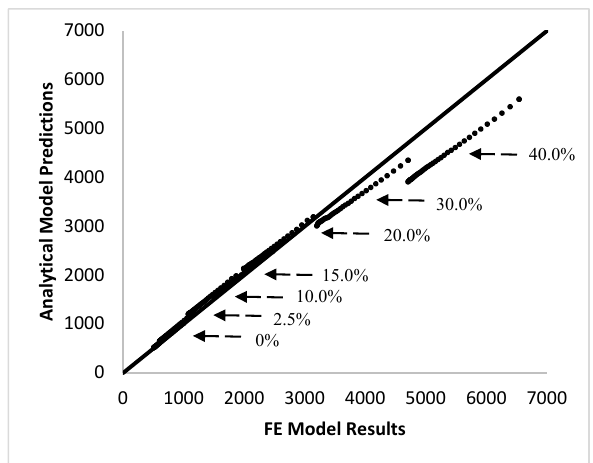
Figure 3. Comparison of the analytical model predictions to the finite element (FE) simulation results shows good agreement between the two at low volume fraction; however, at volume fractions equal to 30% and greater, the finite element results deviate from the predictions of the analytical model.